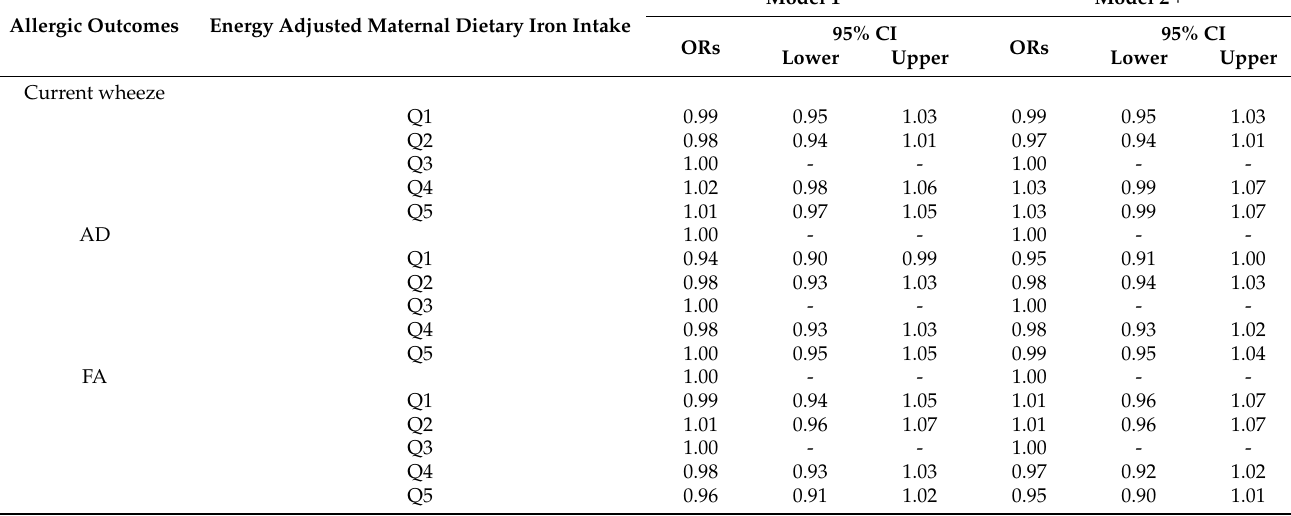
Table 4. Odds ratios from generalized estimating equation models evaluating the association of energy adjusted maternal dietary iron intake with wheeze, atopic dermatitis and food allergy in